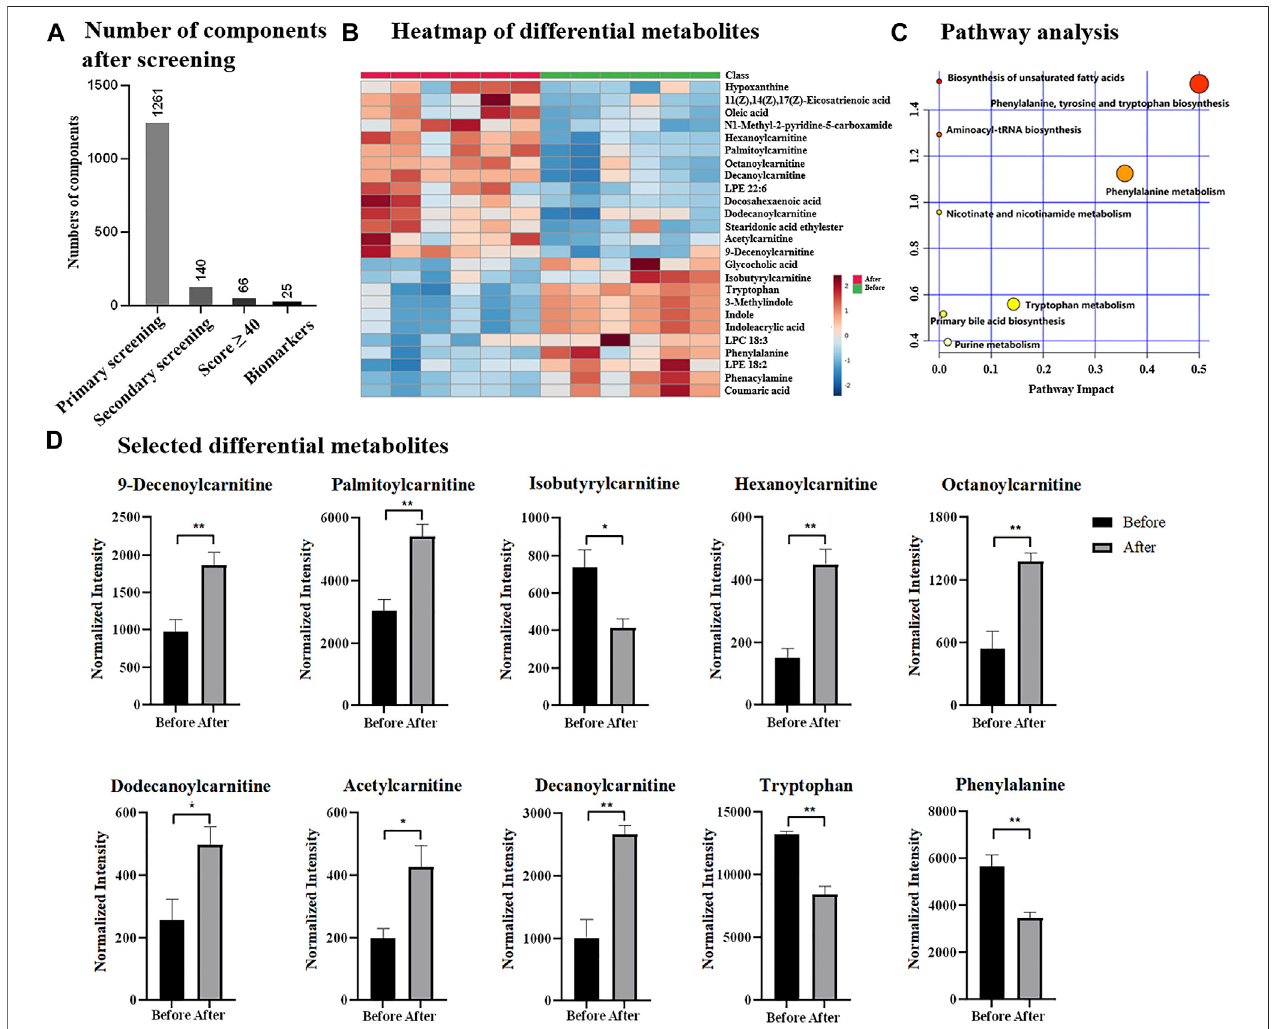
FIGURE 4 | (A) Number of components after designed screening steps; (B) heatmap of differential metabolites; (C) pathway analysis; (D) selected differential metabolites before and after chemotherapy.